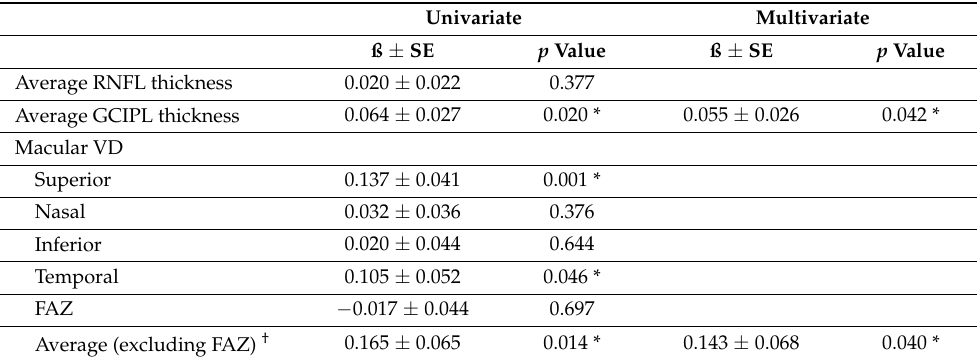
Table 6. Factors associated with the N95 amplitude in mild to moderate glaucoma (MD ≥ − 12 dB) ( n = 64). Univariate Multivariate ß ± SE p Value ß ± SE p